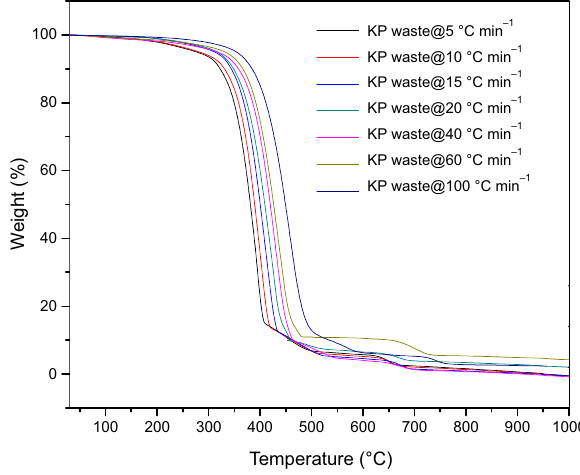
Figure 3. Thermogravimetric analysis plot (weight loss vs. temperature) of keyboard plastic waste at 5, 10, 15, 20, 40, 60 and 100 °C/min heating rates